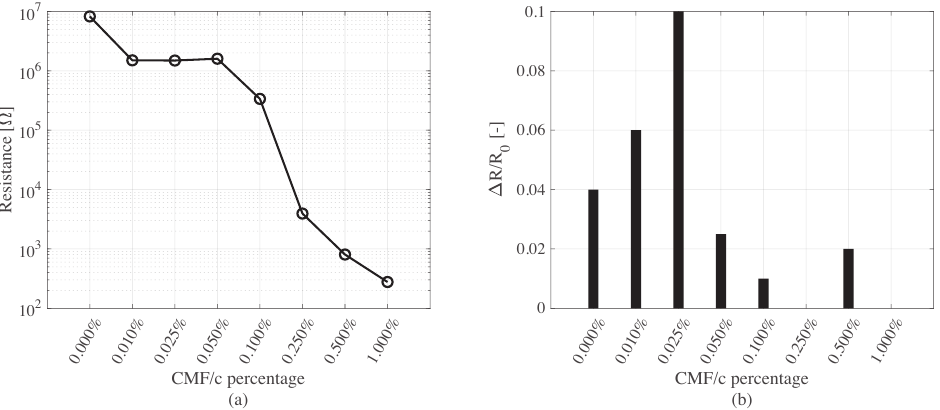
Figure 7. The results of the percolation study ( a ) and sensitivity tests ( b ) done on small smart concrete cube samples.